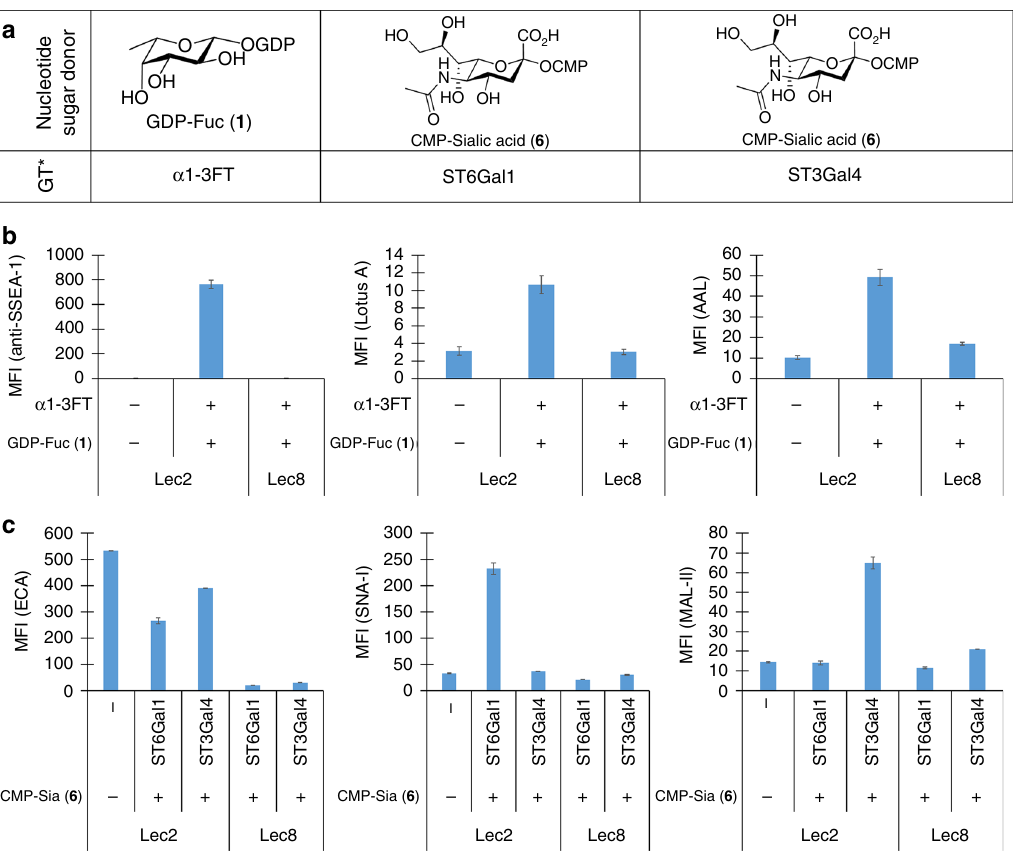
Fig. 2 Validate the speci fi city of in situ glycosylation strategy. a Nucleotide sugar donors and glycosyltransferases used to form three glycan epitopes (Le X , Sia α 2-3Gal β 1-4GlcNAc, Sia α 2-6Gal β 1-4GlcNAc) on the cell surface (*GT = glycosyltransferase). b Flow cytometry data presented in bar graph for validating cell-surface in situ fucosylation. CHO cells were modi fi ed via in situ fucosylation using the donor GDP-Fuc ( 1 ) and α 1-3FT . The modi fi ed cells were probed with a fl uorescently labeled lectin or antibody and analyzed by fl ow cytometry ( n = 3, error bars are reported as the standard error of the mean (SEM)). c Flow cytometry data presented in bar graph for validating in situ sialylation. CHO cells were modi fi ed via in situ sialylation using the donor CMP-Sia ( 6 ) and the sialyltransferase ST6Gal1 or ST3Gal4. The modi fi ed cells were probed with a fl uorescently labeled lectin and analyzed by fl ow cytometry ( n = 3, error bars are reported as